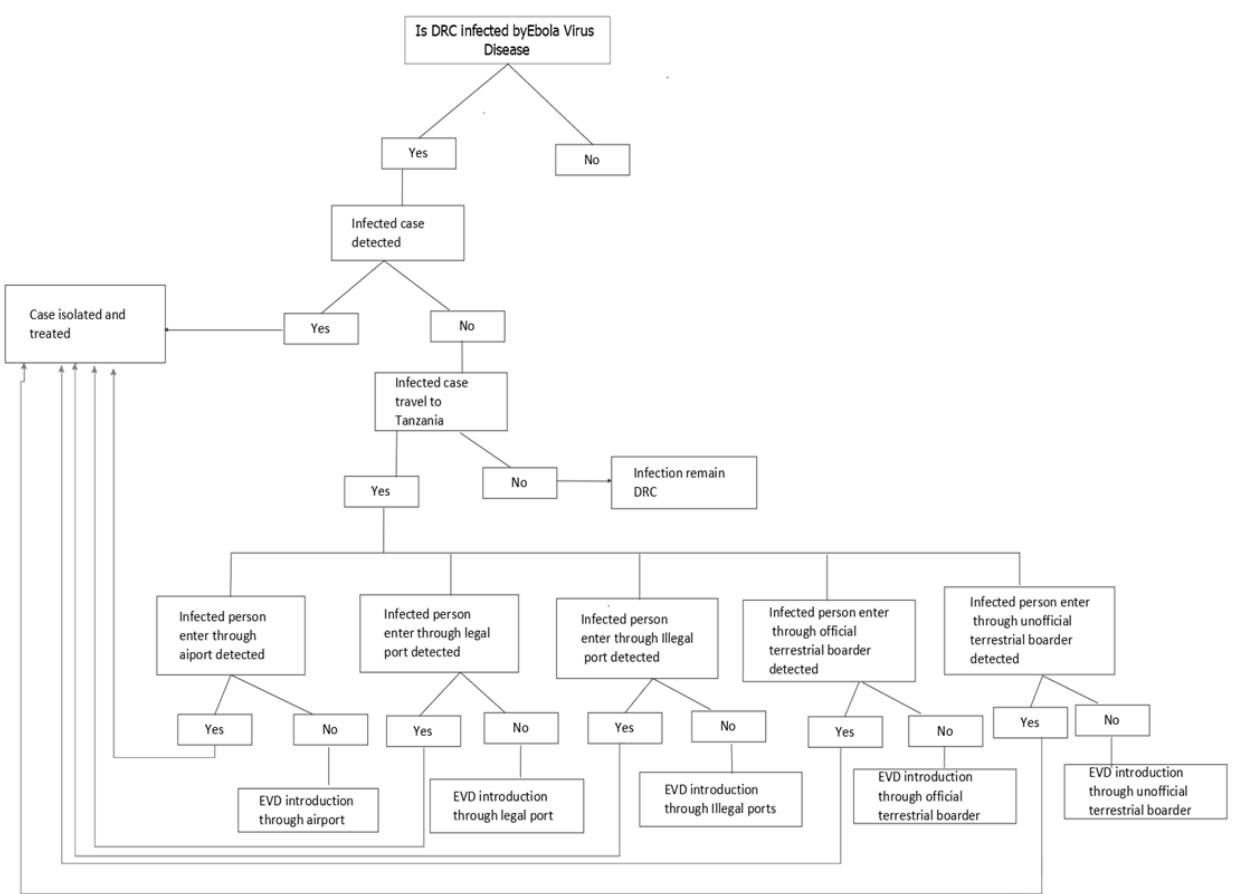
Figure 1. Scenario event pathways for the release of EVD to Tanzania.